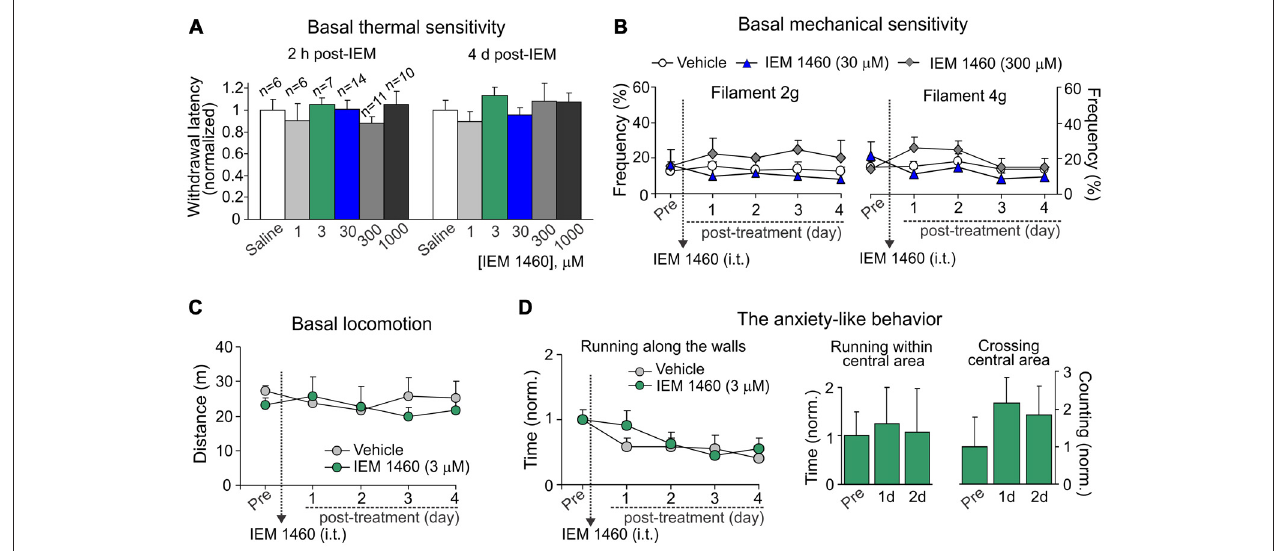
FIGURE 4 | Dicationic compound IEM-1460 does not give rise to detectable side effects. (A) The Hargreaves test demonstrates that treatment with IEM-1460 at different concentrations produces neither acute nor delayed changes in thermal peripheral sensitivity. Data are expressed as the mean paw withdrawal latencies normalized to the correspondent time-point in the saline-treated group. (B) The von Frey behavioral test shows no changes in the mechanical peripheral sensitivity in response to the 2 g (left graph) and 4 g (right graph) von Frey monofilaments in rats treated with IEM-1460. Results are presented as mean ± SEM. (C,D) The open-field test demonstrates no significant changes in animal locomotion (C) and the anxiety-like behavior (D) after treatment with 3 µ M IEM-1460. The anxiety-like behavior was assessed by changes in the time of running along the walls (left graph in D ), the time spent within the central area of arena (middle bars in D ) and crossing by animal the arena center (right bars in D ); results are presented as mean values normalized to the correspondent time-point prior to the treatment